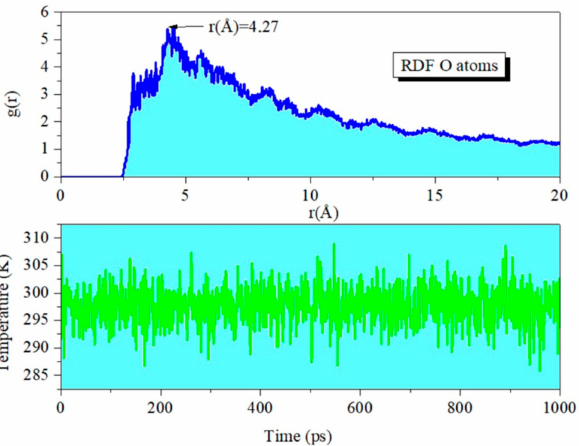
Figure 13. The temperature variation (T = 298 K) and the RDF of the O atoms for the biopolymer CHA molecule found in Artemisia herba-alba stems and